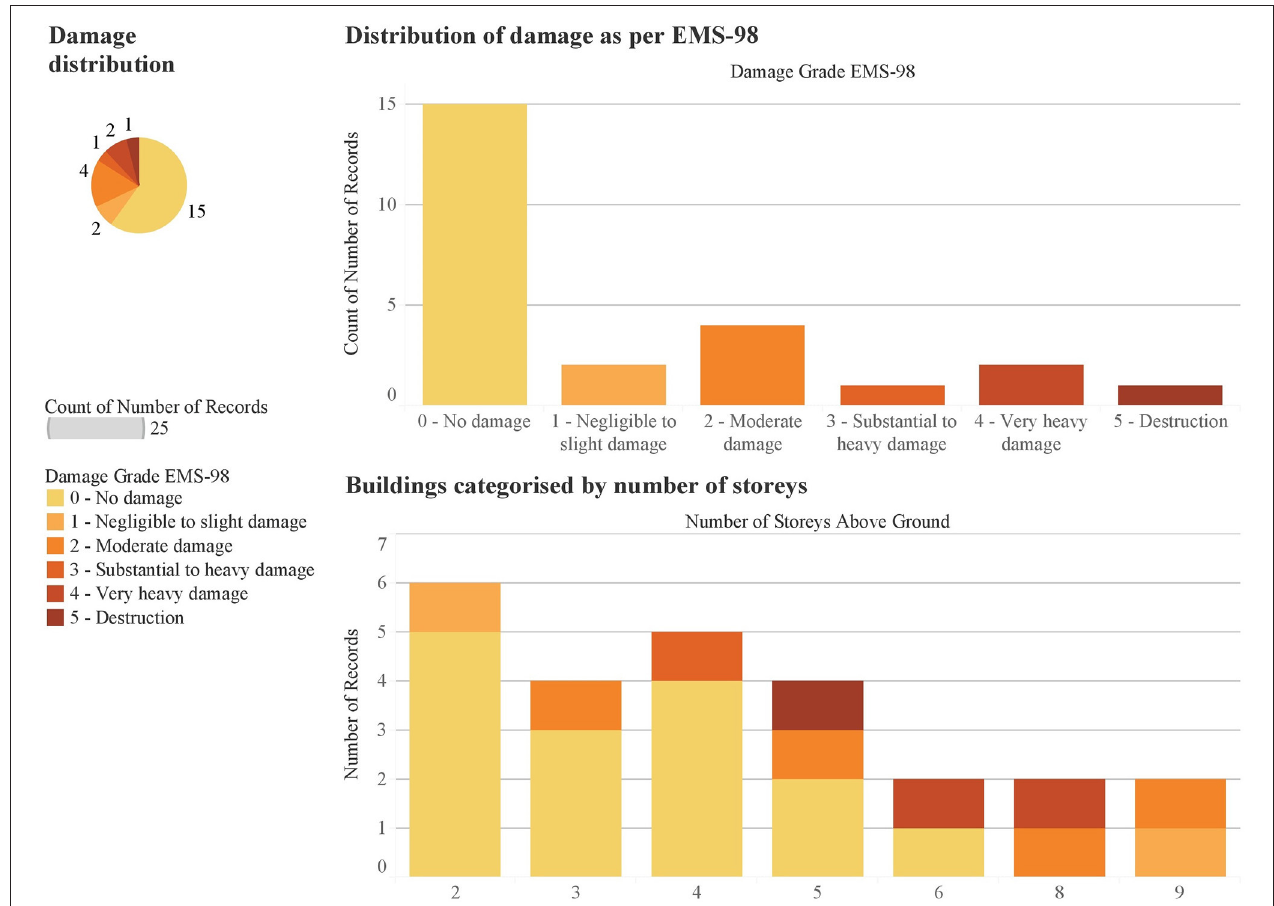
FIGURE 5 | Distribution of damage categories for the 25 buildings studied in the street La Morena. Damage categories as per EMS-98.